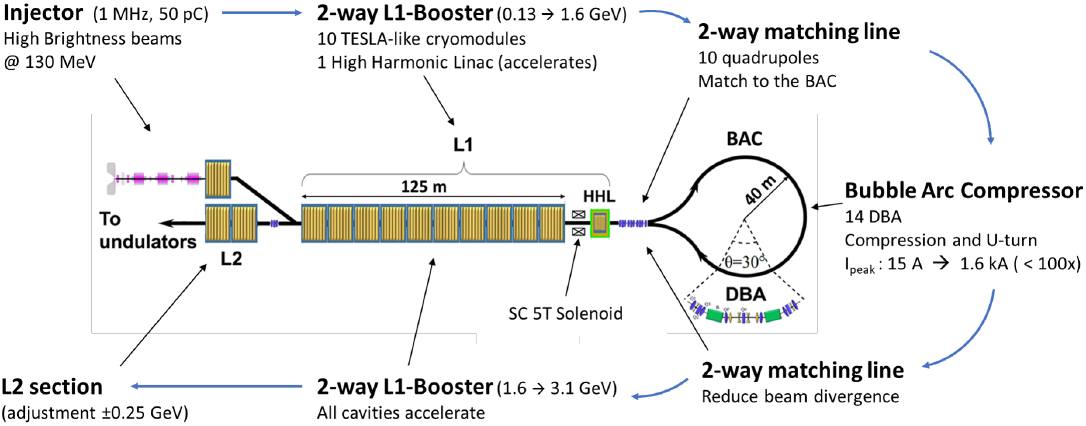
Figure 1. A high brightness injector delivers the beam to the booster linac (region L1) through a dogleg. L1 ends with a high harmonic linac (HHL); then, the beam enters the bubble arc compressor (BAC) used to compress and to perform the beam u-turn. The beam is re-accelerated in L1 and is finally energy-tuned in the linac